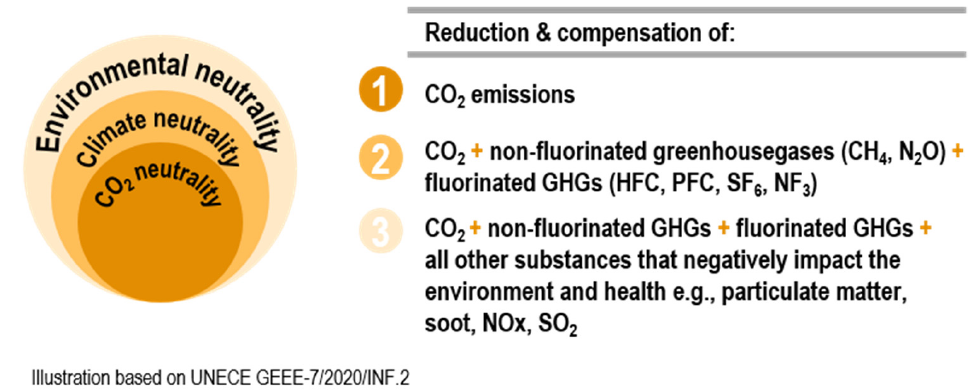
Figure 1. Defining different neutralities and what is needed to achieve them [46,47].